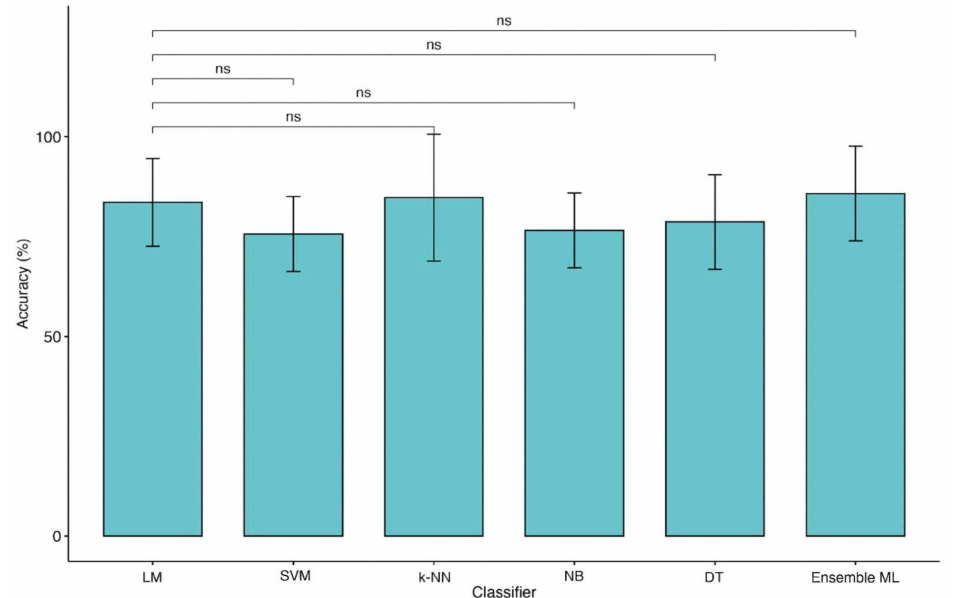
Figure 5. Comparison of accuracies between LM and ML models (4 classes of outcome). Legend: Linear Regression Model (LM), Support Vector Machine (SVM), k-Nearest Neighbors (k-NN), Naïve Bayes (NB), Decision Tree (DT) and Ensemble of Machine Learning models (Ensemble